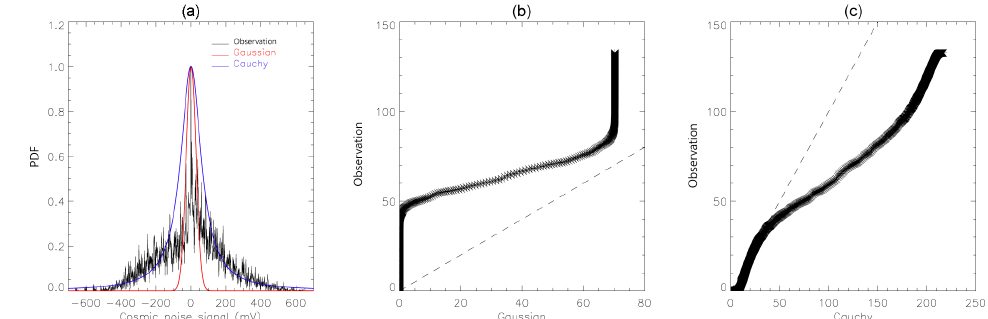
Figure 3. Portrayals of the distribution of the stochastic component (described in the text) of the cosmic noise signal. Left: probability density function with fitted Gaussian (red) and Cauchy (blue) distributions superimposed (explained and discussed in the text). Centre: Q–Q plot of the observed data versus Gaussian; right: Q–Q plot of the observed data versus